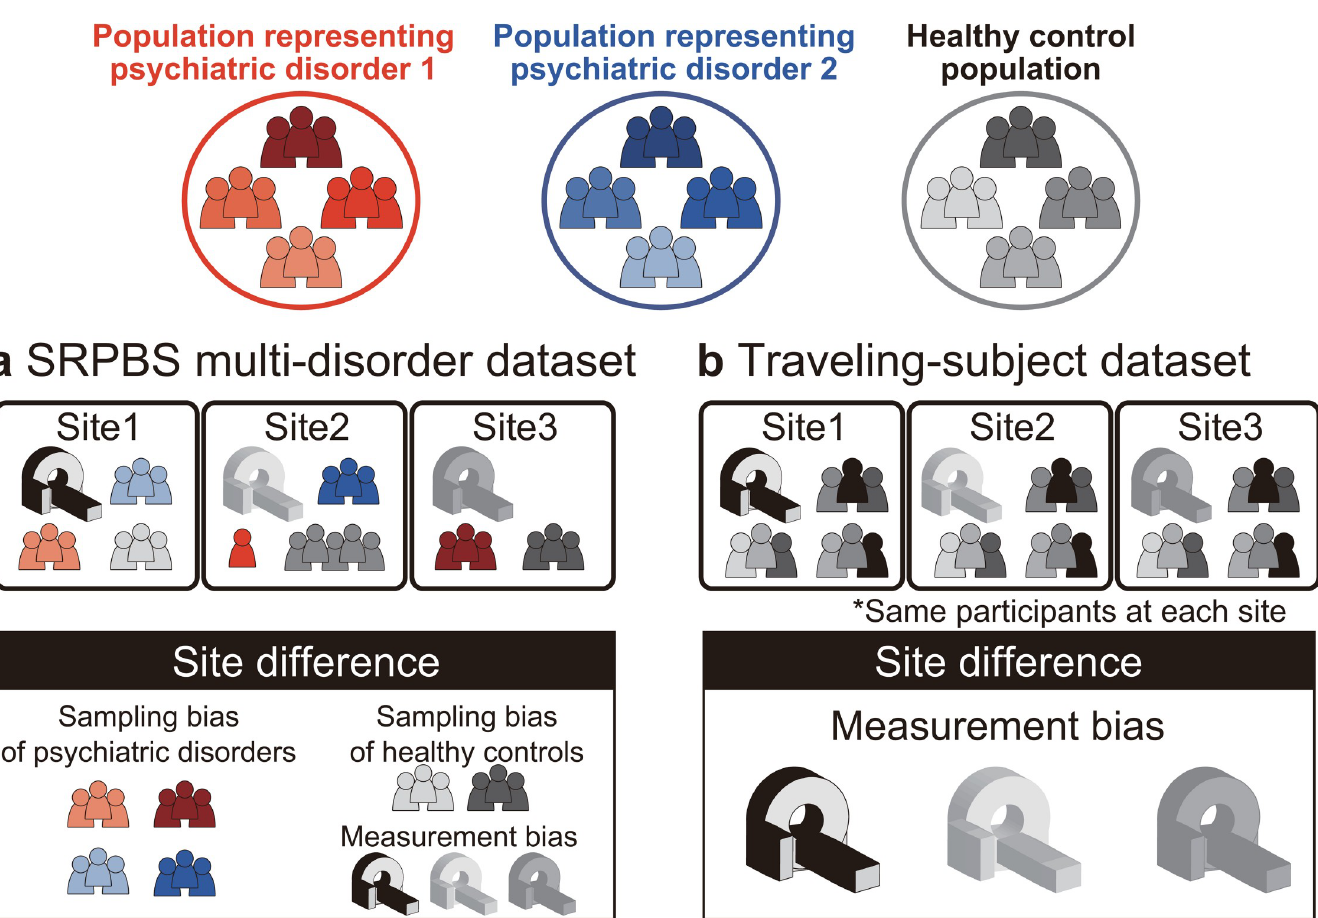
Fig 1. Schematic examples illustrating the two main datasets. (a) The SRPBS multidisorder dataset includes patients with psychiatric disorders and healthy controls. The number of patients and scanner types differed among sites. Thus, site differences consist of sampling bias and measurement bias. (b) The traveling-subject dataset includes only healthy controls, and the participants were the same across all sites. Thus, site differences consist of measurement bias only. SRPBS, Strategic Research Program for Brain